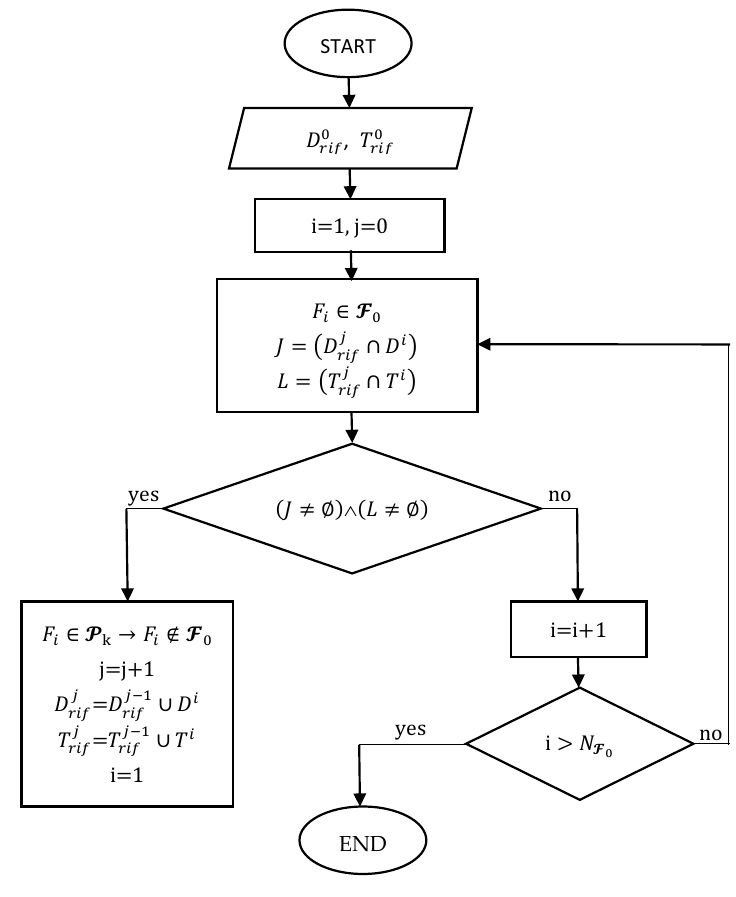
Figure 11. The flowchart of the algorithm.